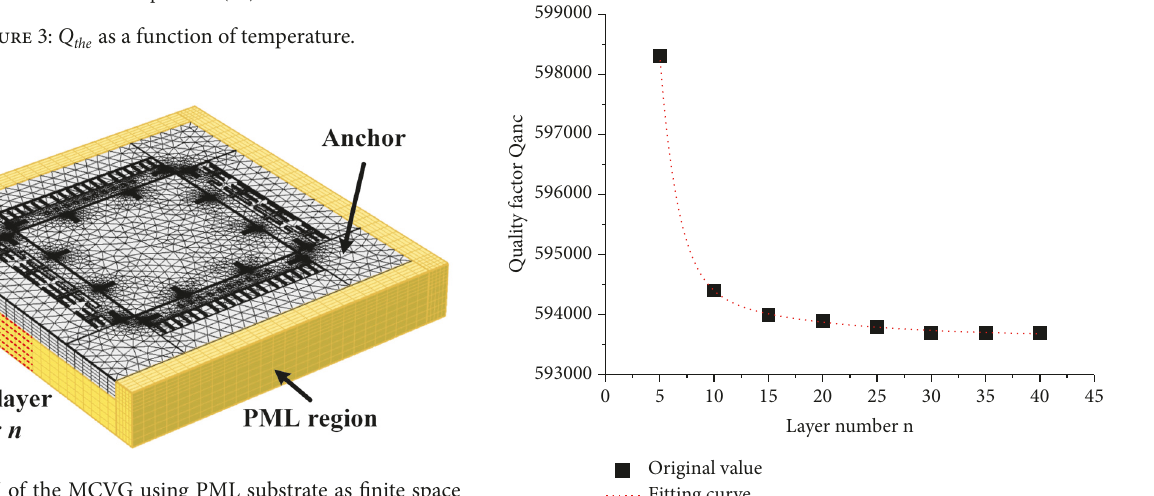
Figure 4: FEM of the MCVG using PML substrate as finite space marked in yellow.